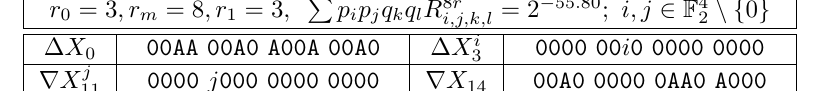
Table 6: Specification of a dedicated boomerang distinguisher for 14 rounds of CRAFT